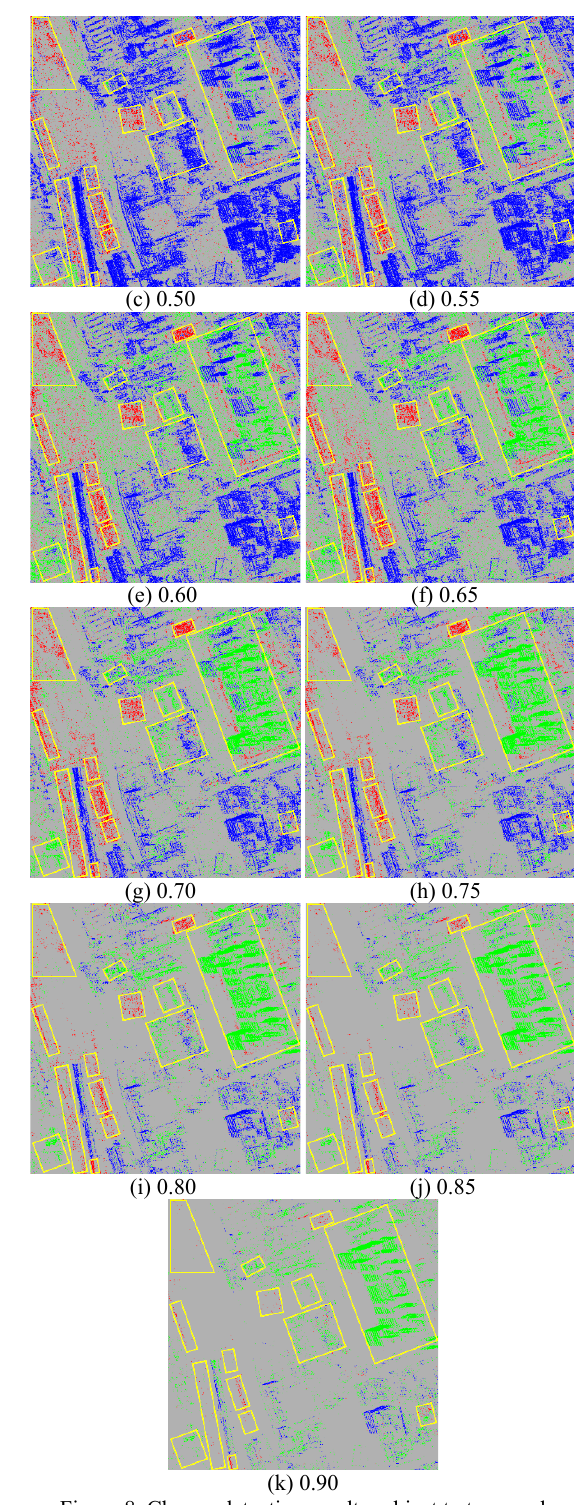
Figure 8. Change detection results subject to temporal coherence thresholds (from 0.4 to 0.9). Steady, disappearing, and emerging structures represented by PS (blue), DBC (red), and EBC (green) points. Yellow square, building